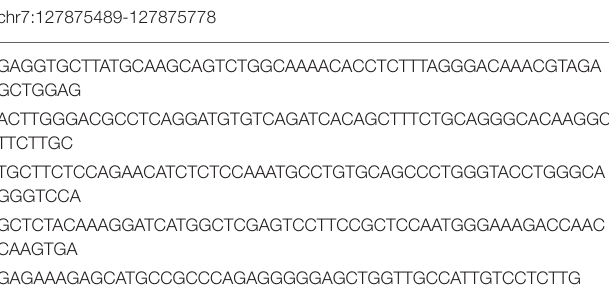
TABLE 3 | Upstream sequence of LEP